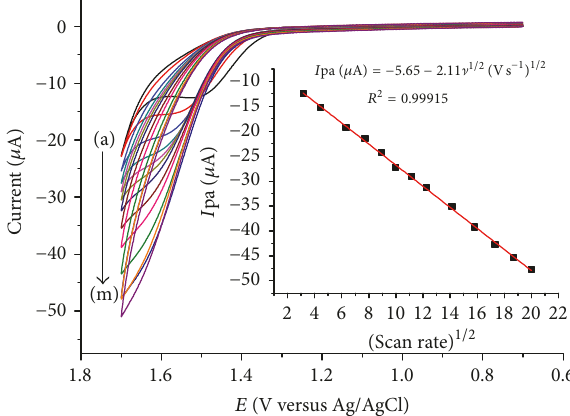
Figure 2: Cyclic voltammograms of lignin modified GCE at pH 5 ABS containing 1mM caffeine at different scan rates ((a)–(m): 10, 20, 40, 60, 80, 100, 125, 150, 200, 250, 300, 350, and 400 mVs −1 , resp.). Inset: plot of oxidative peak current as a function of the square root of scan